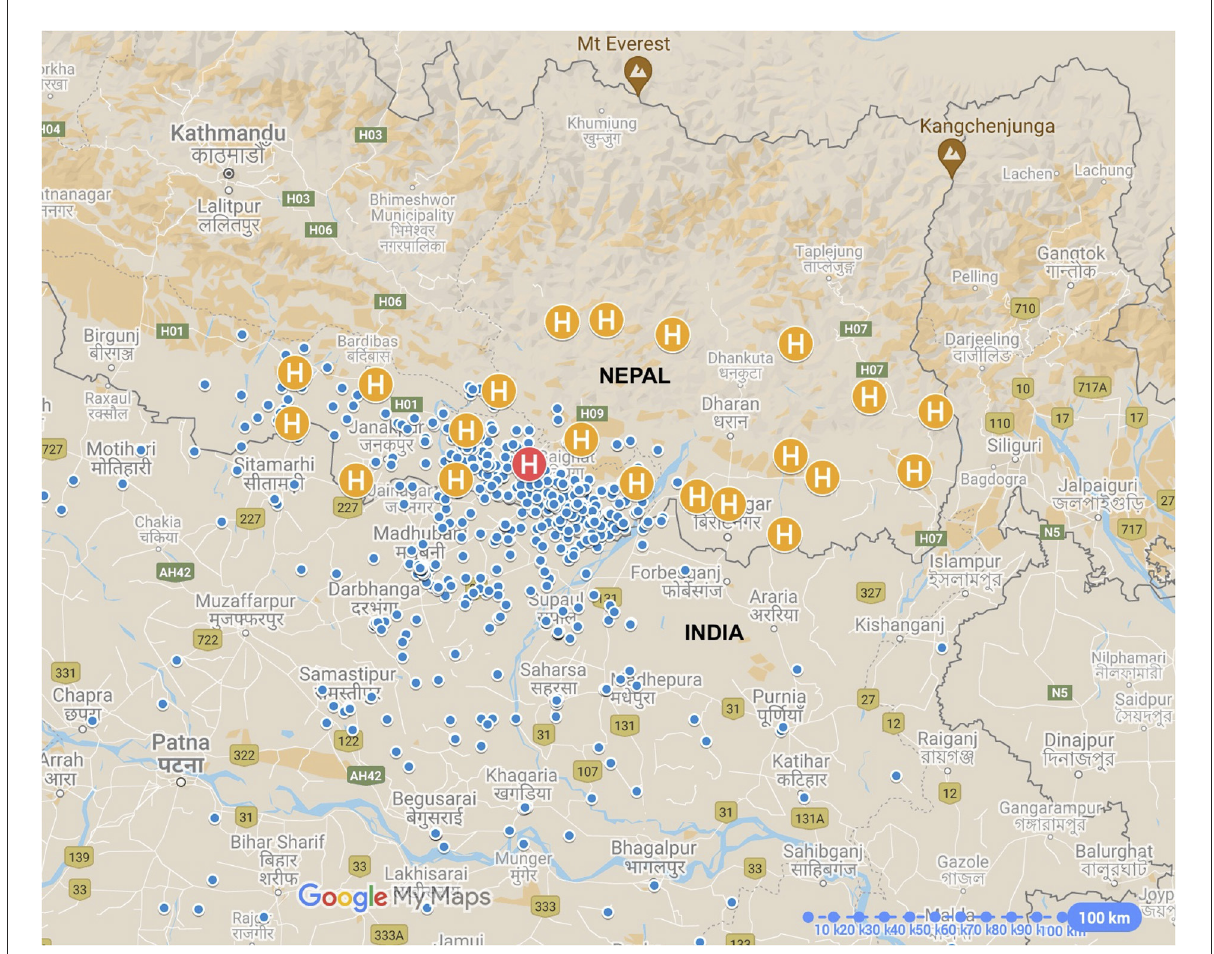
FIGURE1 Map of eastern Nepal and north-eastern India showing patients’ homes (blue pins) in relation to Sagarmatha Choudhary Eye Hospital (SCEH, red “H” pin) and Eye Care Centers (Orange “H” pin”). Not all positions are shown as some patients attended from outside of this map area. International borders shown as solid gray